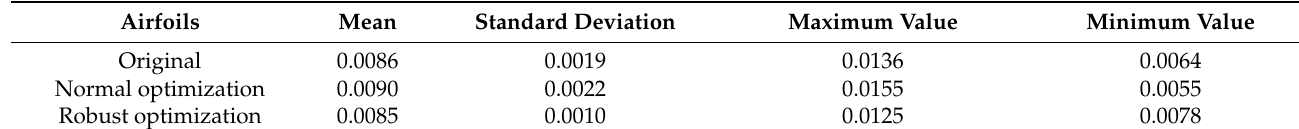
Table 4. Comparison of optimization results.